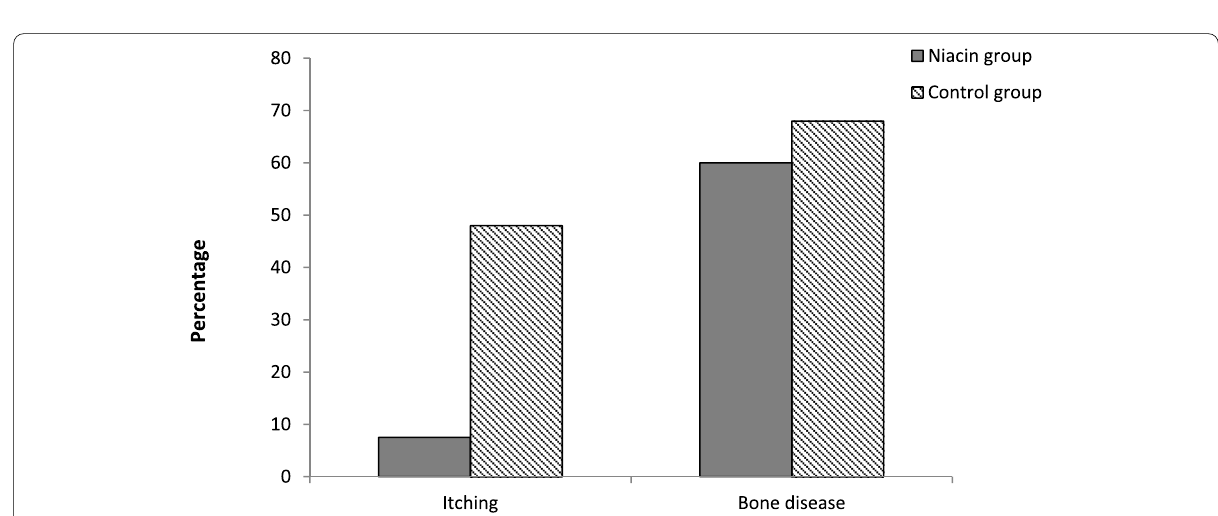
Fig. 5 Sixth month follow‑up: itching and mineral bone disease among studied